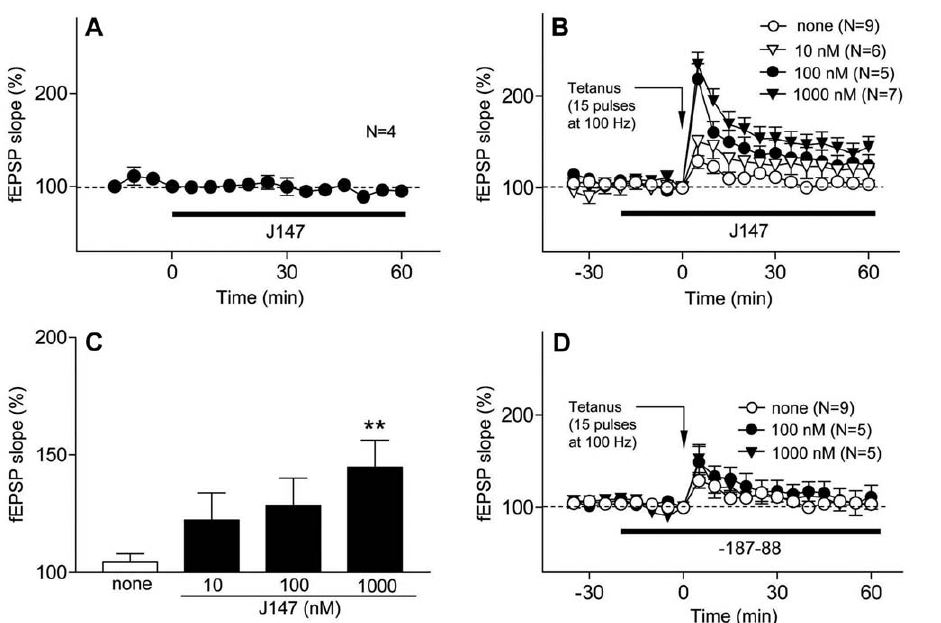
Figure 3. J147 Facilitates the Induction of LTP in Schaffer Collateral CA1 Pyramidal Cell Synapses in Rat Hippocampal Slices. (A) Effect of J147 (1 m M) on basal synaptic transmission. Hippocampal slices were exposed to J147 during the time indicated by the black bar. The fEPSP slope is expressed as the percentage of the value immediately before the addition of J147. J147 does not affect basal synaptic transmission. (B) J147 facilitates the induction of LTP after a weak tetanic stimulation (15 pulses at 100 Hz) which alone does not induce LTP in control slices. The effect of N J147 is concentration-dependent. Time course of changes in the fEPSP slope. The hippocampal slices were untreated (o, n=9) or exposed to J147 ( . , , 1 m M, n=7) for the time indicated by the black bar and weak tetanic stimulation was applied at time 0. The fEPSP 0.01 m M, n=6; m , 0.1 m M, n=5; slope is expressed as the percentage of the value immediately before the application of weak tetanic stimulation. (C) Concentration-dependency. To compare the data among the groups, the averages of the fEPSP slopes 30–60 min after tetanic stimulation were calculated as an index of LTP magnitude. J147 demonstrated a concentration dependent effect with 1000 nM having the greatest effect on the fEPSP slope (n=7 slices per rat: N one-way ANOVA F(3,23)=4.4, ** P =0.01). (D) Negative Control. 2 187–88, the alkene form of J147 in which nitrogens are replaced by carbons (o, n=9; m , 0.1 m M, n=5; , 1 m M, n=5) showed no effect. All data shown are means 6 SEM. doi:10.1371/journal.pone.0027865.g003 PLoS ONE |